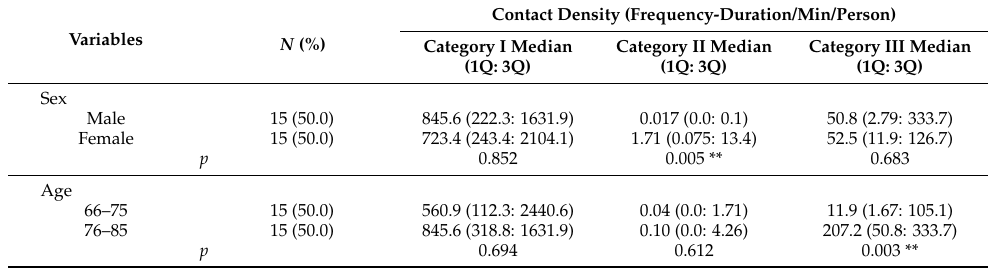
Figure 1. Histogram for the distribution of contact density by subgroups of equipment. Note: Y is the probability density of the frequency of a person. X is the contact density (frequency-duration/min) reflecting the contact frequency and contact duration during the 2-hours observation time. Category I: Equipment used by individuals (personally used equipment); Category II: Equipment mainly used by individuals but occasionally by other person, and Category III: Equipment used for public use (commonly used equipment). Table 4. Differences in density of hand to environments contact by participants’ characteristics (2-hours observation time, n = 3930, N = 30 person)